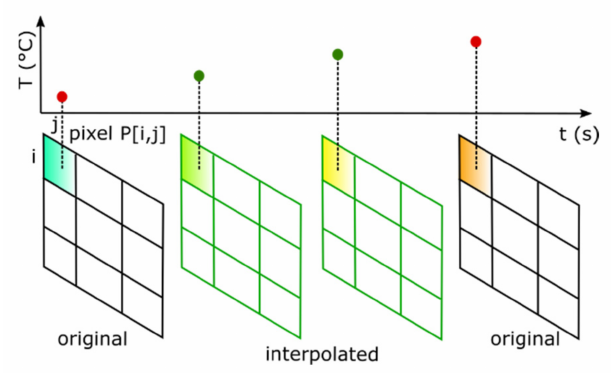
Figure 5. Concept of the temporal interpolation of the thermogram sequence.